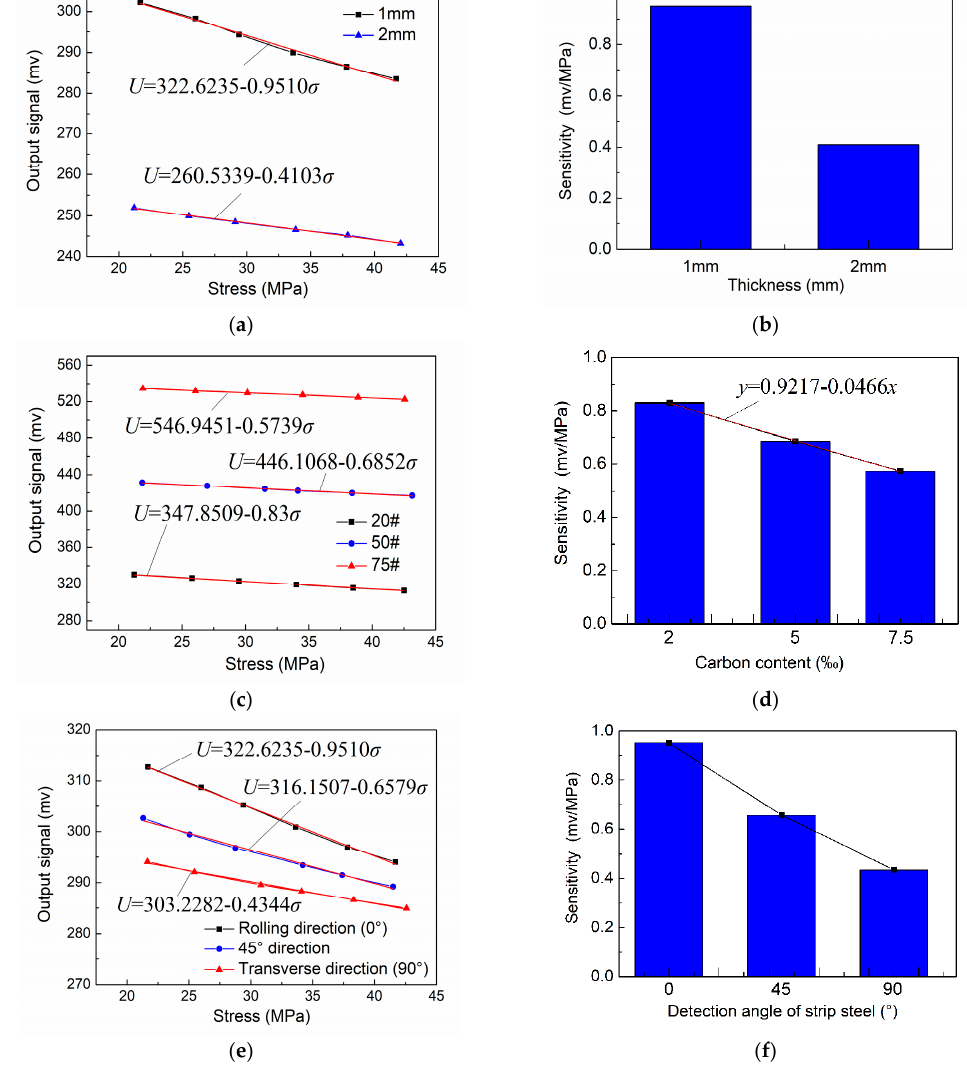
Figure 8. Analysis of influence factor for stress detection signal: ( a ) detection signal of strip steel with different thickness; ( b ) relationship between plate thickness and signal sensitivity; ( c ) detection signal of strip steel with different carbon contents; ( d ) relationship between carbon content and signal sensitivity; ( e ) detection signal in all directions of strip steel; and ( f ) relationship between different directions of strip steel and signal sensitivity.